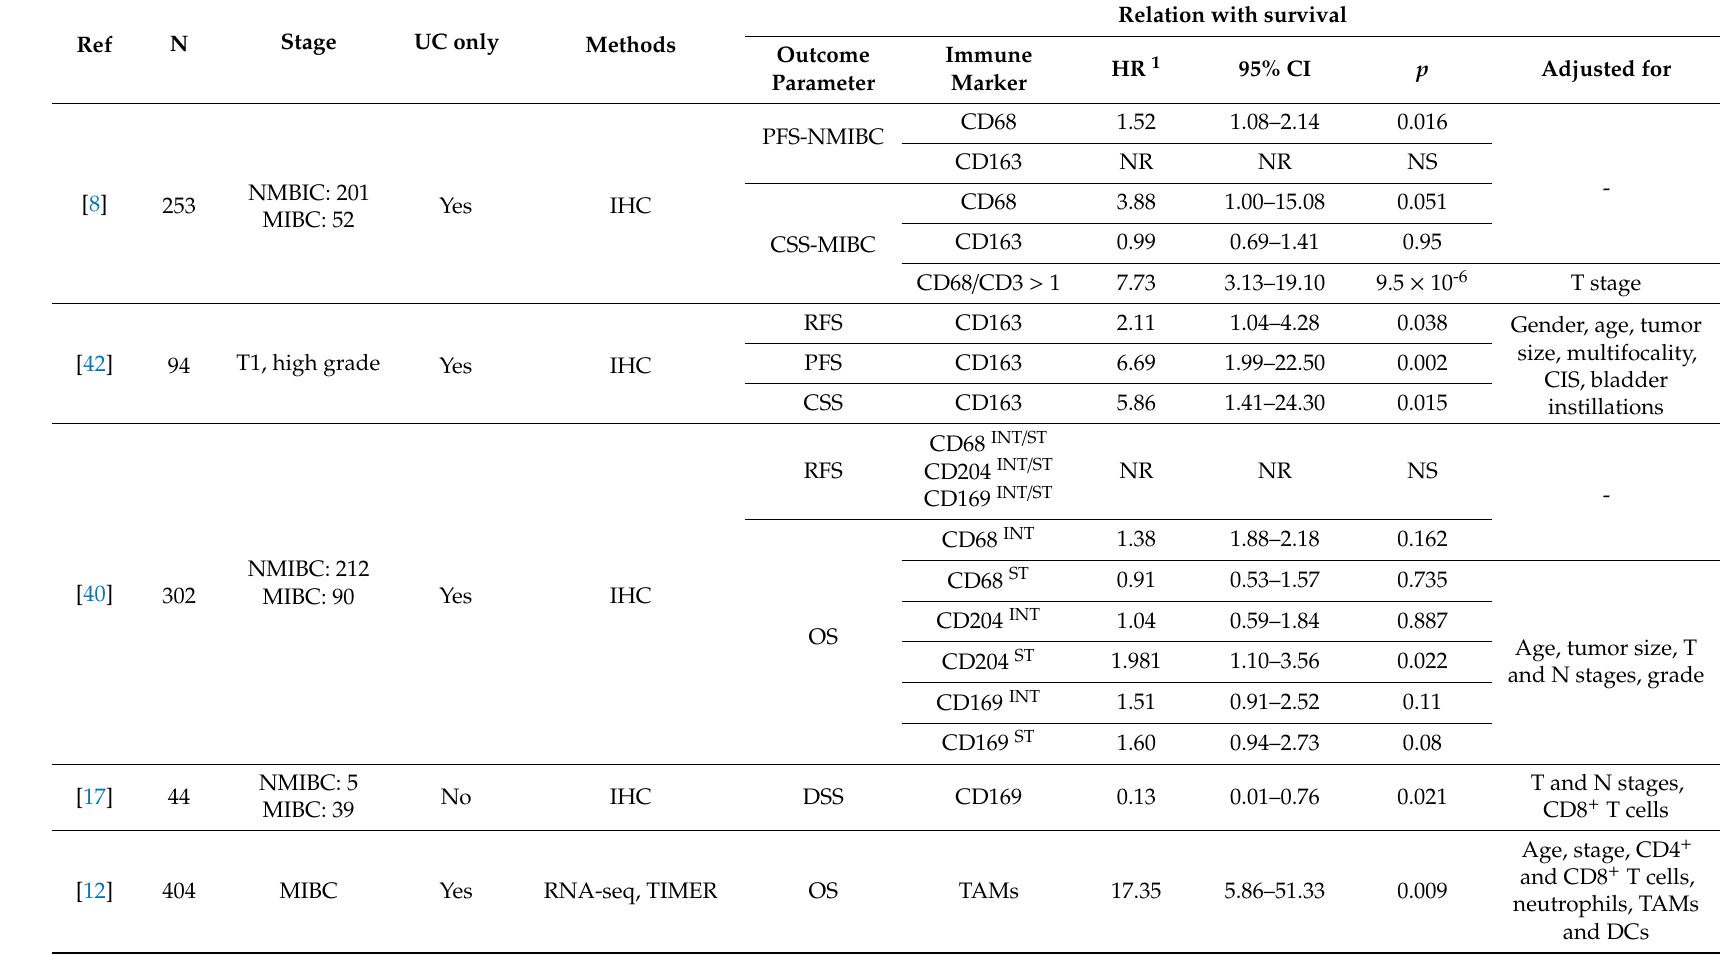
Table 2. Prognostic value of macrophages in